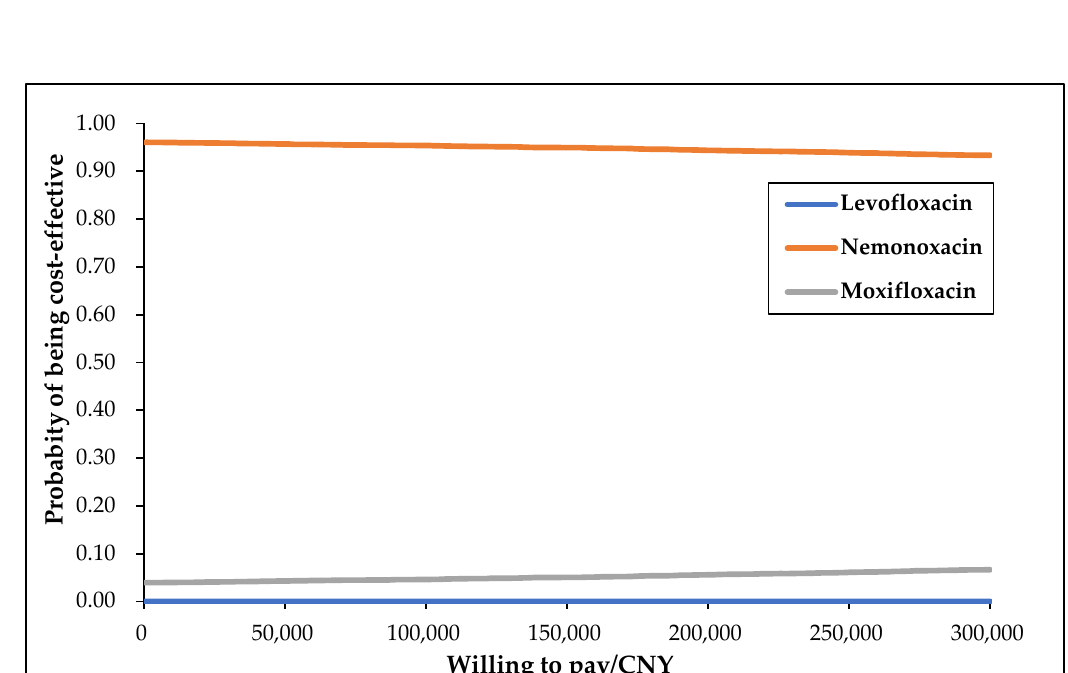
Figure 3. Scatter plot ( A ) and cost-effective acceptability plot ( B ).